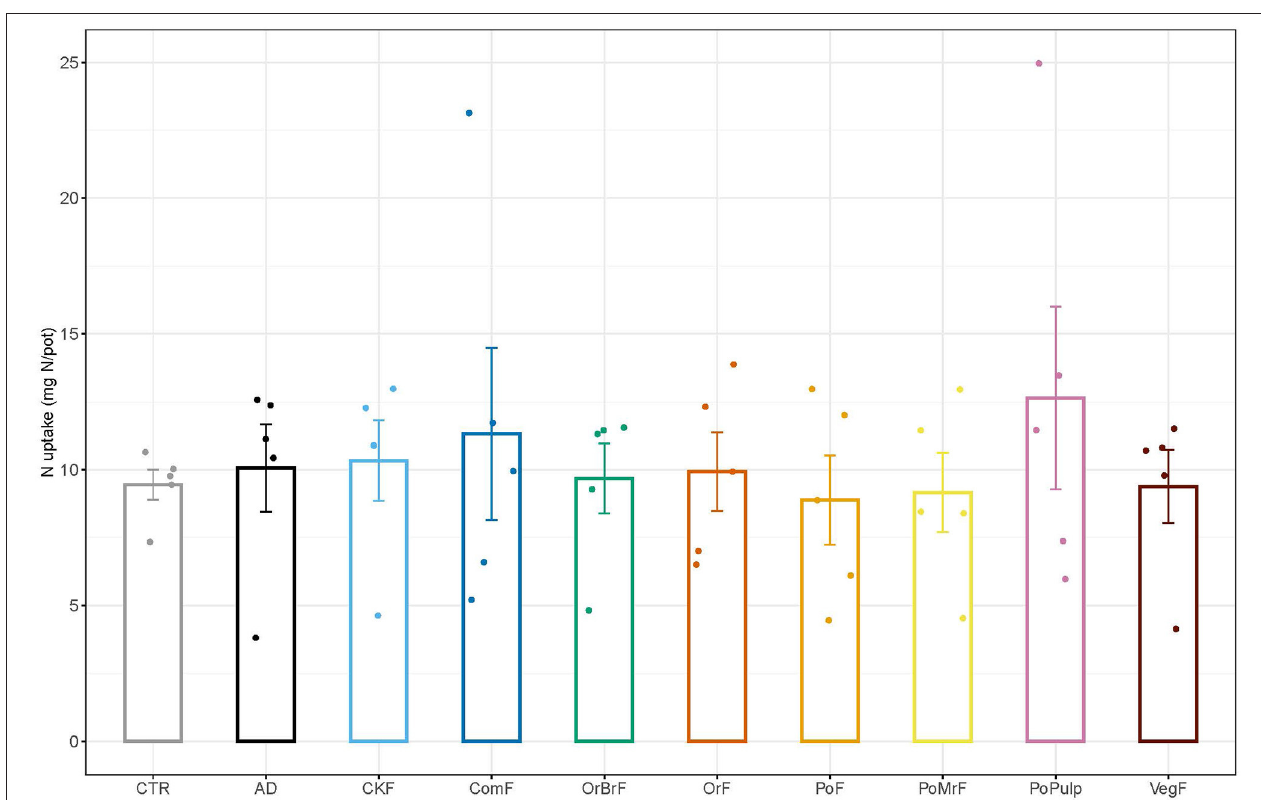
FIGURE 7 | Mean values of N uptake (mg/pot) of the maize plants at the end of the plant growth pot experiment ( n = 5 ± SE).